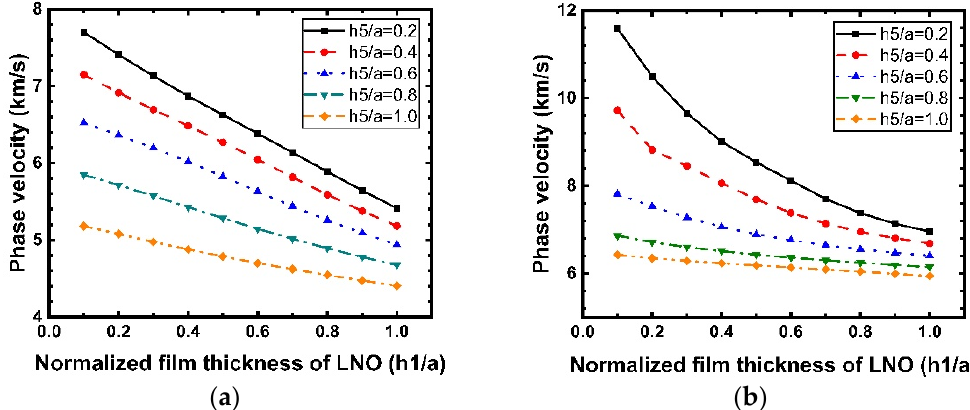
Figure 11. Dispersion curves of the Rayleigh and Sezawa waves velocity calculated for various values of ℎ (cid:2869) /𝑎 for the structure SiO 2 /IDT/LiNbO 3 /diamond/Si. ( a ) Rayleigh mode; ( b ) Sezawa mode.